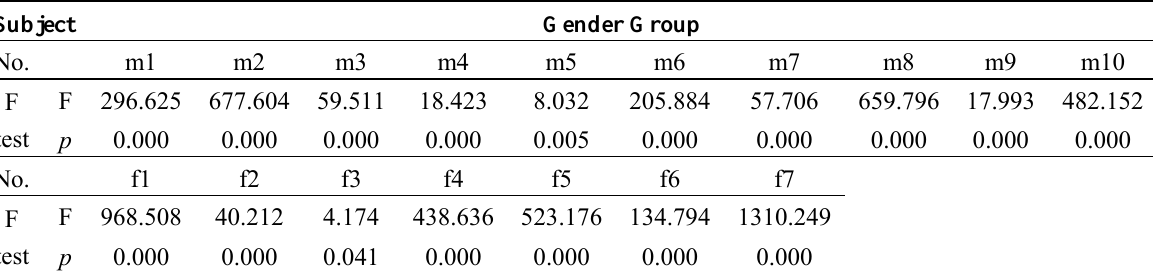
Table 1. Statistical Analysis of Variance